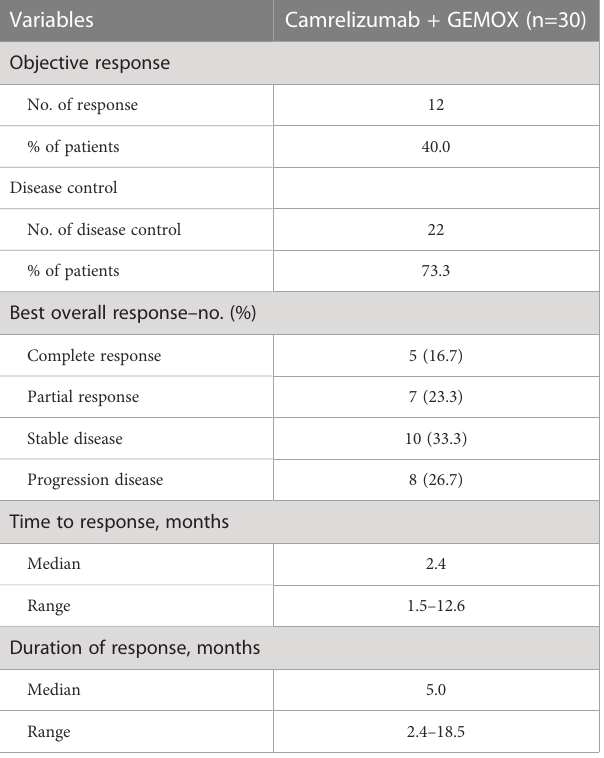
TABLE 2 Clinical ef fi cacy of camrelizumab plus GEMOX in patients with advanced intrahepatic cholangiocarcinoma.